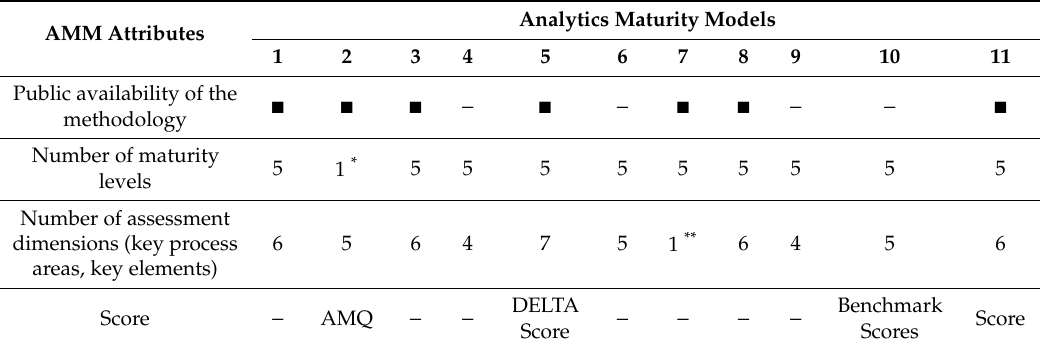
Table 2. A comparative analysis of selected attributes of an organization’s analytics maturity models